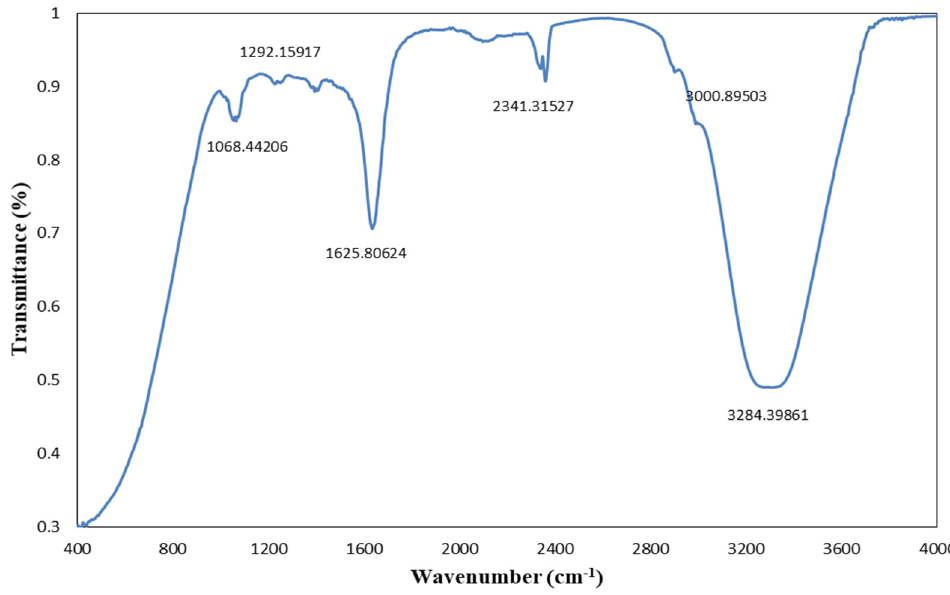
Figure 4. FTIR spectra of M. macroura leaf extract.